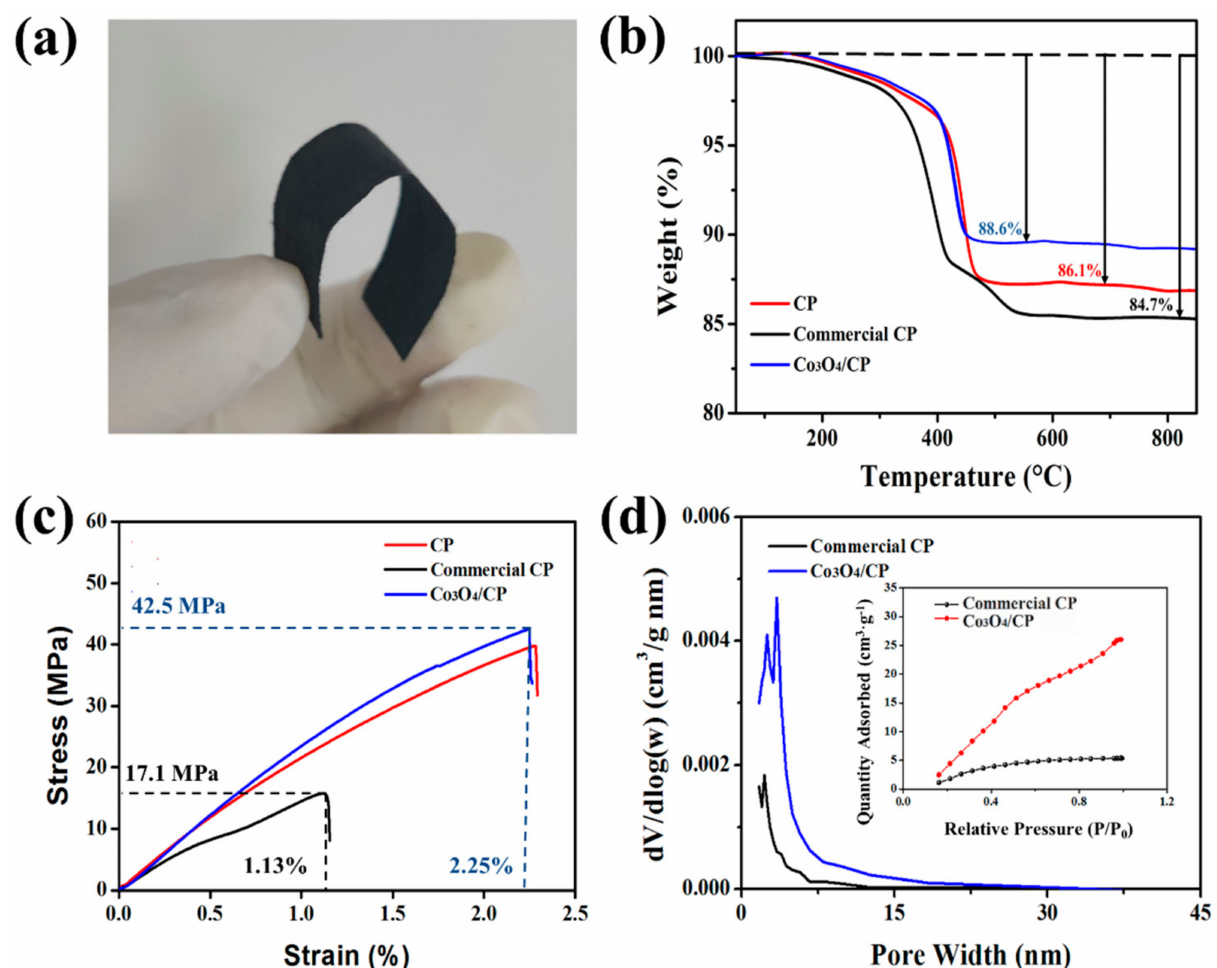
Figure 5. ( a ) Schematic photo of Co 3 O 4 /CP; ( b ) TGA spectra of CF, Co 3 O 4 /CF, Co 3 O 4 /CP; ( c ) Tensile performance test of CP, commercial CP, Co 3 O 4 /CP; ( d ) Nitrogen desorption